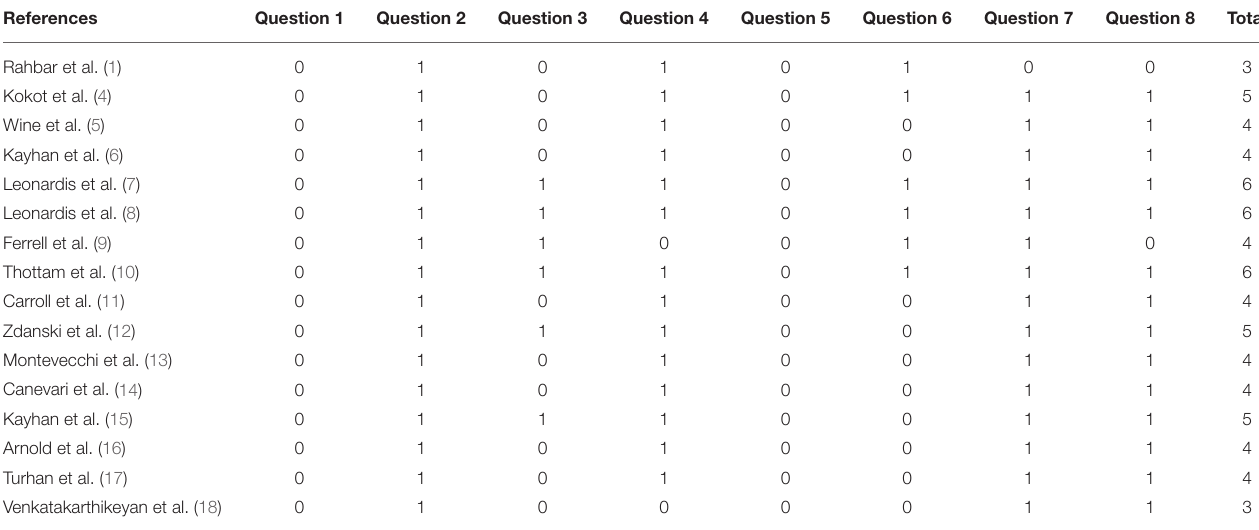
TABLE 4 | National Institute for Health and Care Excellence (NICE) methodology checklist for quality assessment of case